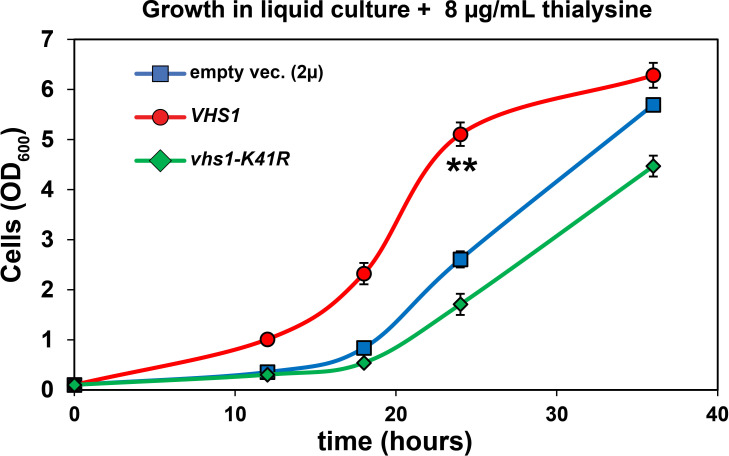
Analysis of cell tolerance to thialysine of yeast cells overexpressing VHS1 or a kinase dead (vhs-K41R) variant (kinase dead).SUB280 cells expressing wildtype ubiquitin were transformed with VHS1 or vhs-K41R (in 2µ multicopy plasmid pRS327) and grown in lysine-dropout synthetic liquid media supplemented with 8 µg/mL thialysine. OD600 of cells were measured in different time points and the results were plotted as means of four biological replicates (n=4) with ± SD expressed as error bars. Double asterisk (**) indicates p value < 0.001 at the 12, 18, and 24 hr time points using a Student’s t-test, which was only observed for yeast overexpressing wildtype VHS1. For all statistical analysis associated with this figure supplement, p values are reported in the Figure 4—source data 1.